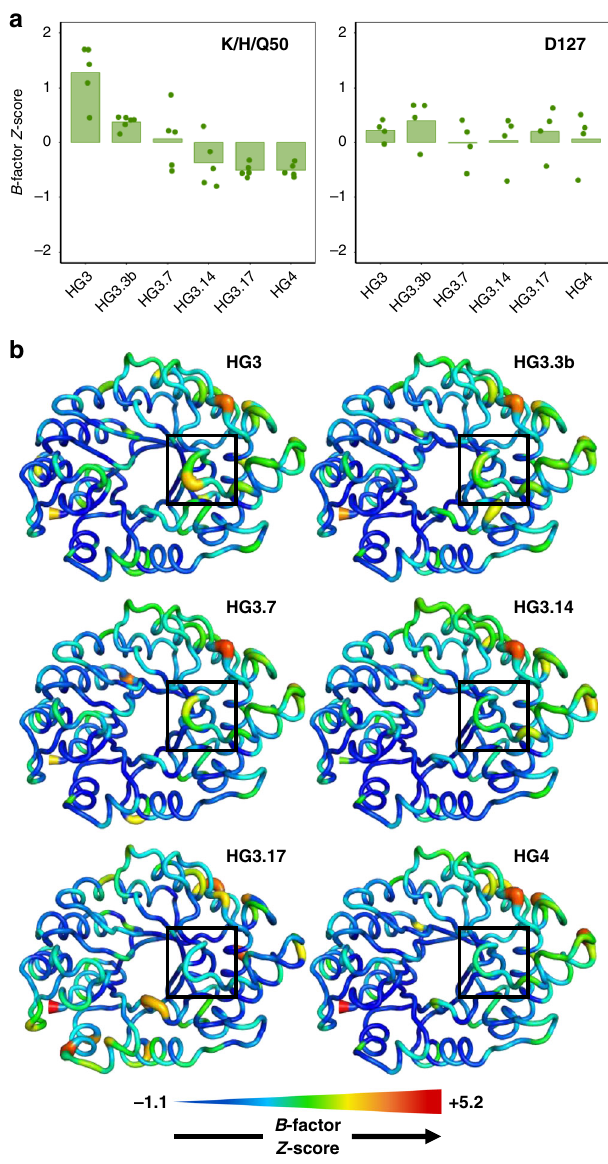
Fig. 3 Conformational heterogeneity. a B-factor Z-scores for the residue at position 50 in the absence of bound 6-nitrobenzotriazole (6NT) decrease over the course of the evolutionary trajectory, while those for Asp127 do not change signi fi cantly. Z-scores of individual side-chain heavy atoms are shown as dots (values averaged over both chain A and B for all structures except that of HG3.17, which contains a single chain in the asymmetric unit), while the average Z-score for the whole side chain is indicated by the bar. Positive and negative Z-scores indicate increased fl exibility or rigidity relative to the average residue in the protein, respectively. b B-factor Z- scores of each protein residue (average of all side-chain heavy atoms) in the absence of bound 6NT plotted on a model backbone for each Kemp eliminase. Thickness of the sausage plot increases with the B-factor Z- score, indicating increased fl exibility. The loop formed by residues 87 – 90 (boxed) becomes more rigid during evolution. Source data are provided as a source data fi latter amino acid. This trend is also expected when histidine at position 50 is mutated to a glutamine (HG3.3b to HG3.7) given the ability of glutamine but not histidine to hydrogen-bond with the cis peptide formed by residues Gly83 and Cys84 (Fig. 2c). However, rigidity continues to increase at this position between